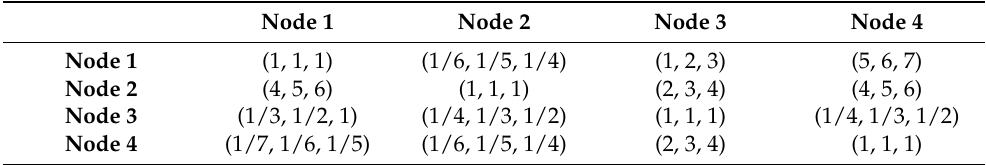
Table A5. Pairwise comparison matrix for No. hops criterion as